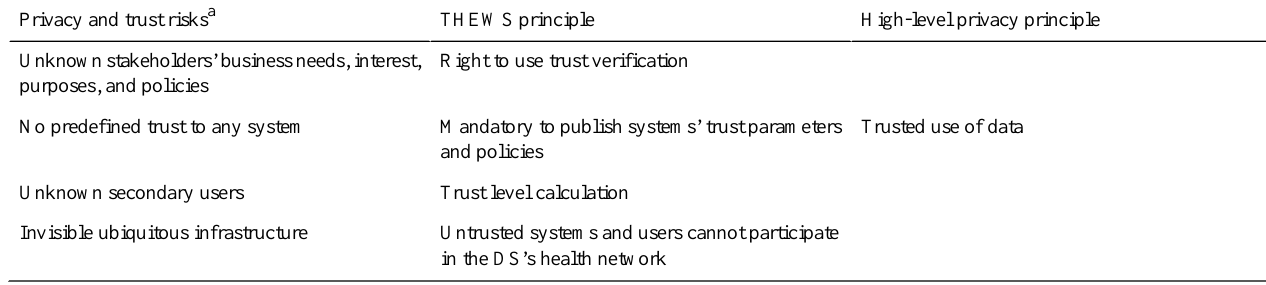
Table 2. Principles of trust